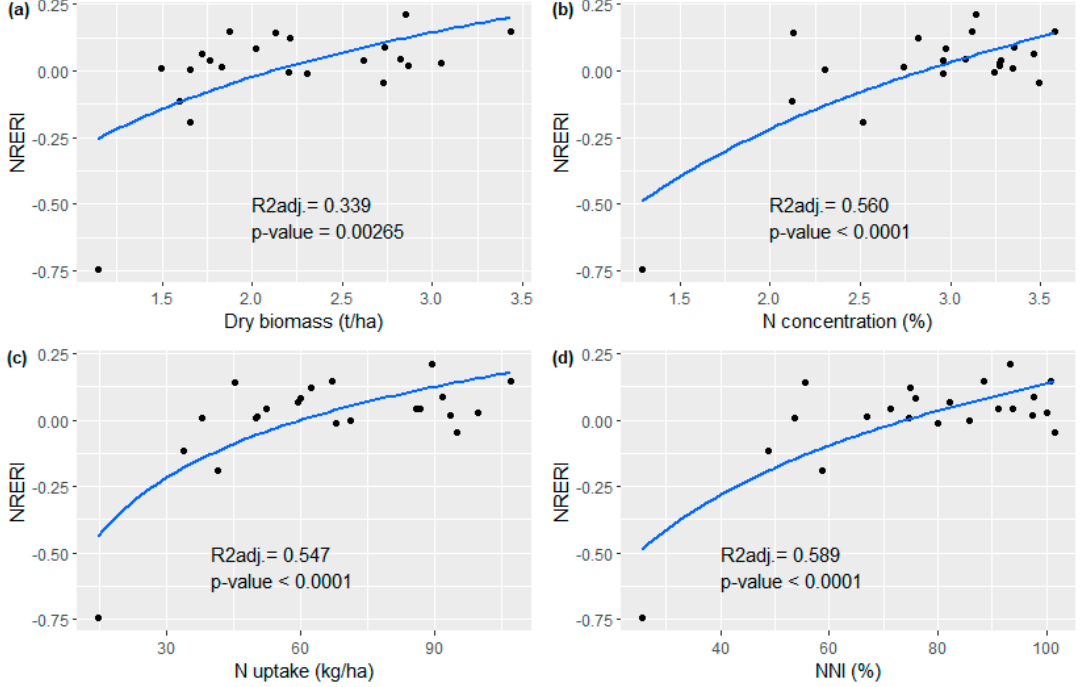
Figure 5. Relationships between NRERI from UAV and spring barley shoot biomass parameters (( a ) biomass dry weight, ( b ) N concentration, ( c ) N uptake, ( d ) NNI) from point sampling of Za Frajmankou and Pod Hvˇezdou fields on 2 June 2021 expressed by logarithmic functions with ad-justed coefficient of determination (R2adj.) and p -value.